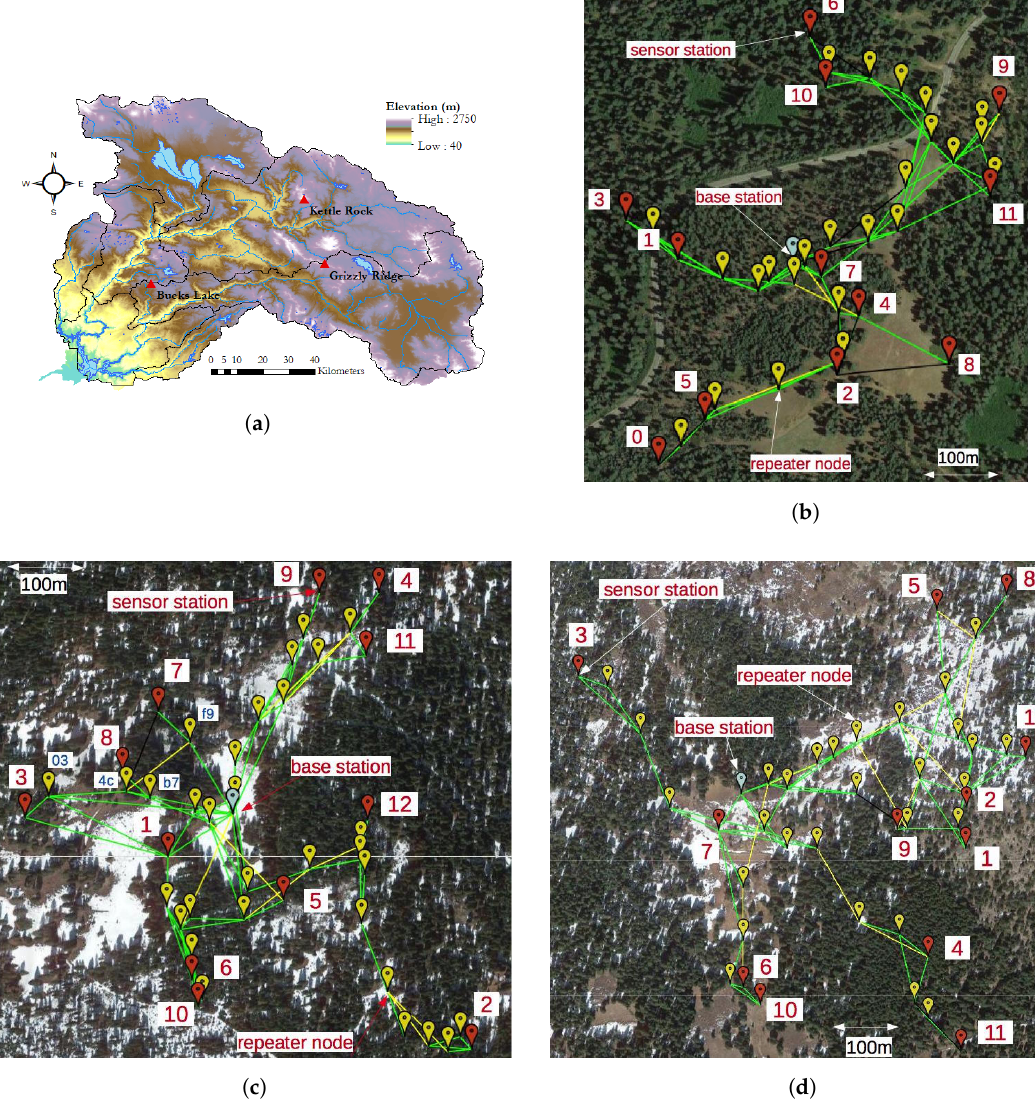
Figure 7. Maps of the deployments: ( a ) Elevation map of the Feather River basin, with the deployment locations indicated; ( b ) Bucks Lake deployment; ( c ) Grizzly Ridge deployment; and ( d ) Kettle Rock